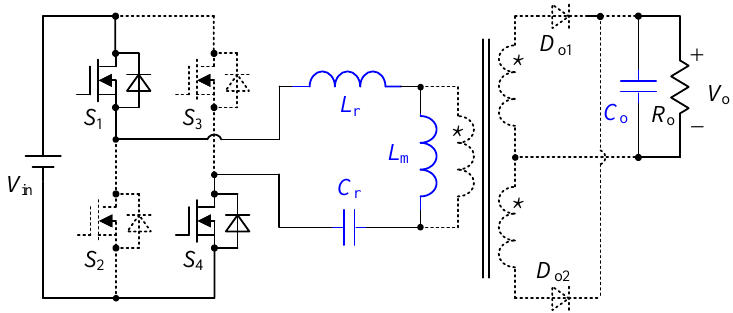
Figure 13. Equivalent circuit of the freewheeling stage of LLC resonant converter.